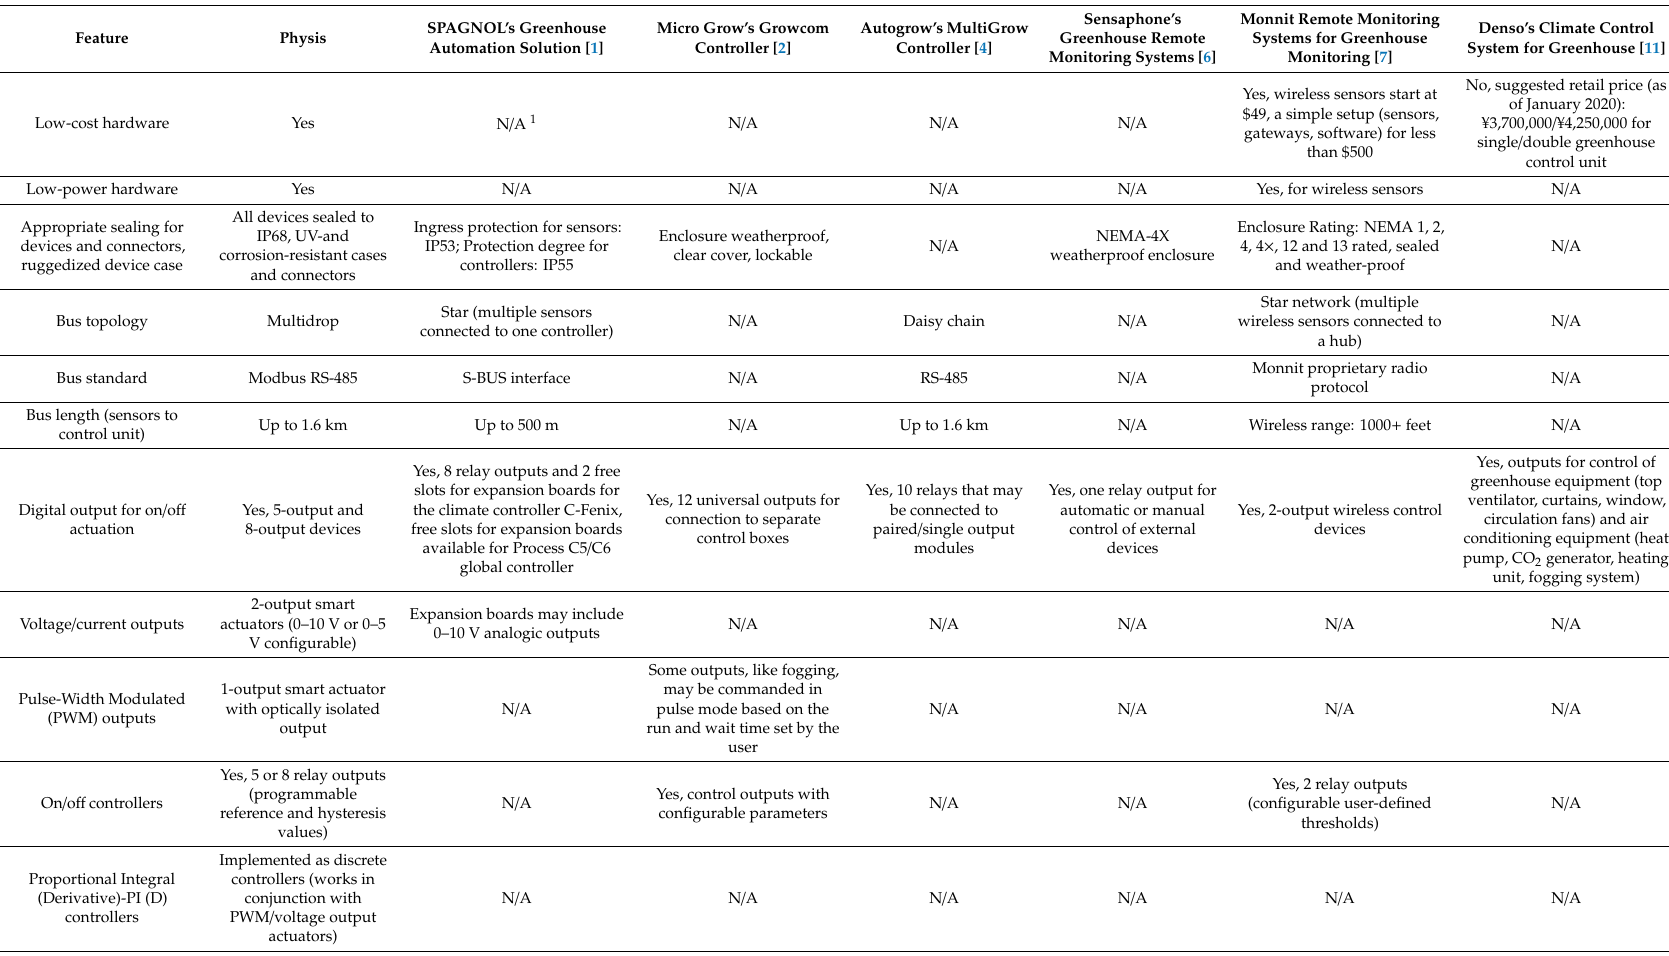
Table 2. Comparative study between the Physis platform and commercially available